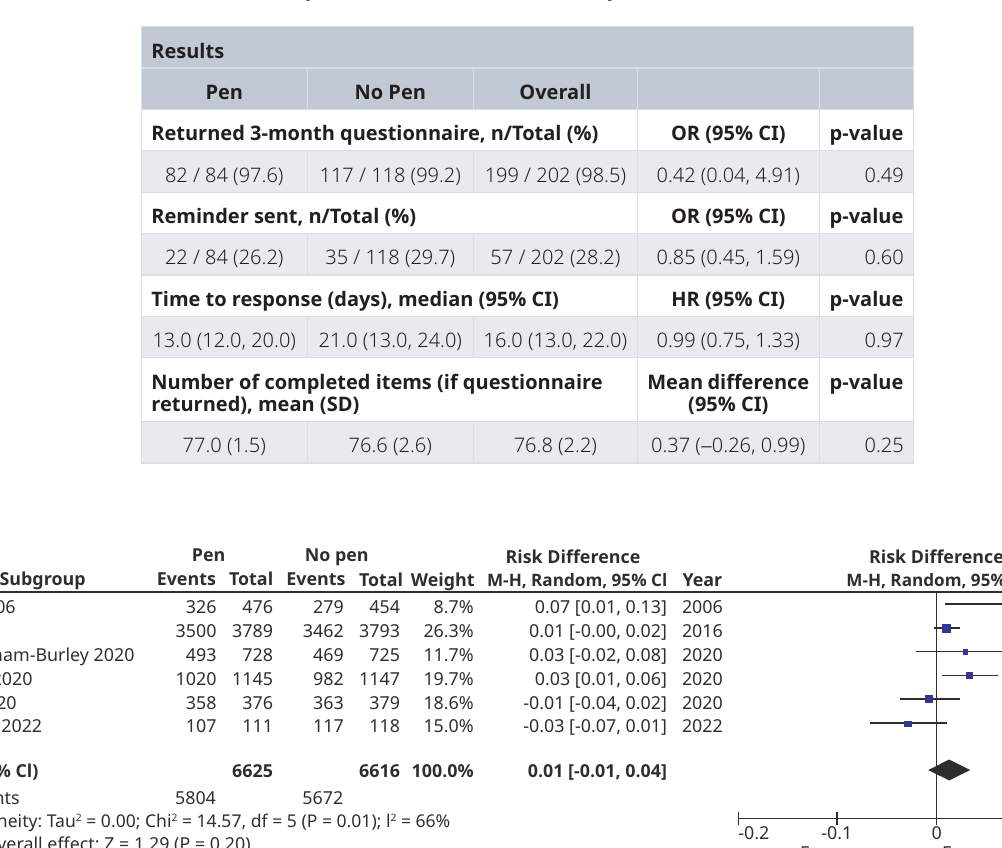
rates.Table 3. Summary of SWAT trial results (PP